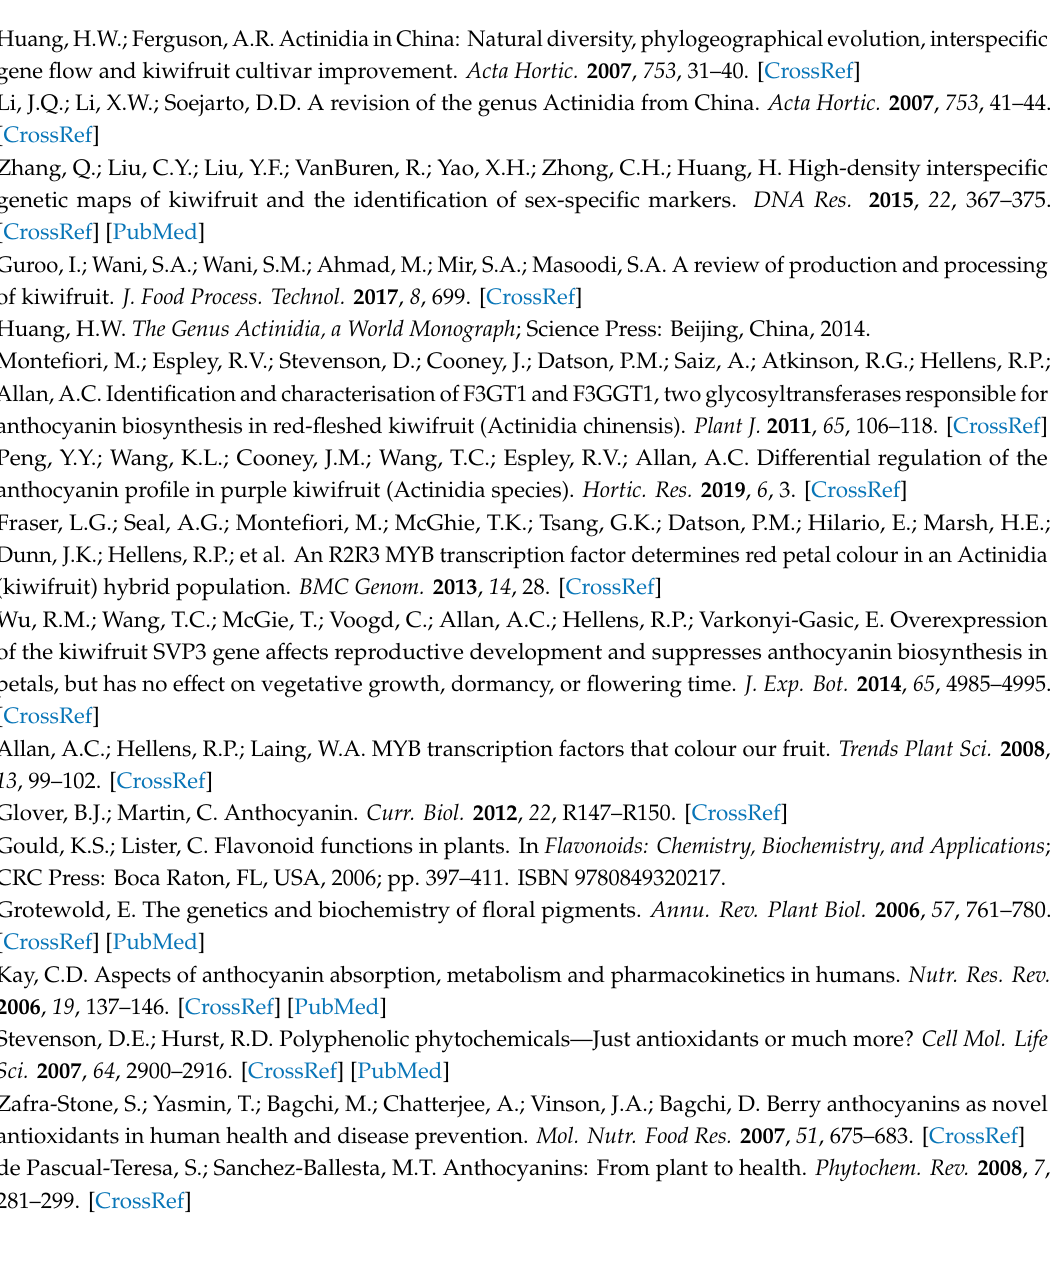
Figure S1: Basic information of AeCHS used for